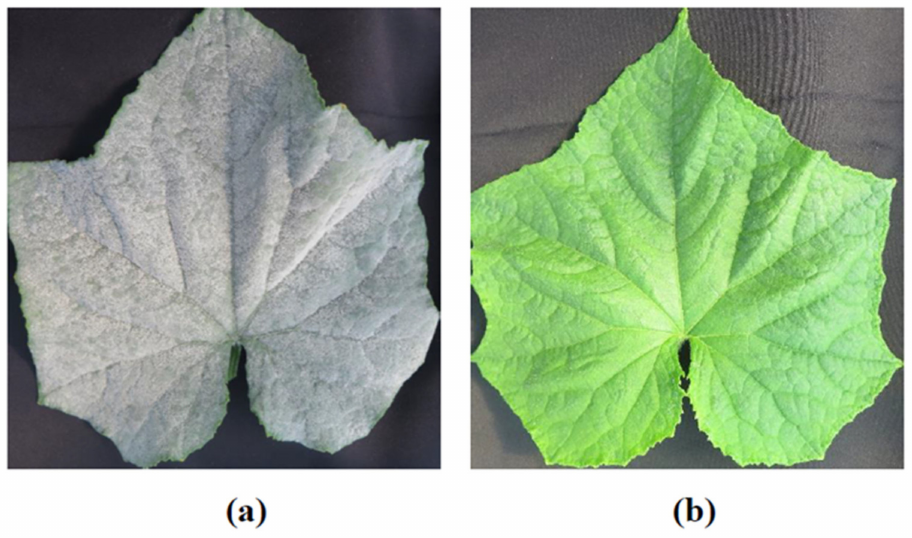
Figure 1. Typical phenotypic responses of PM infection. ( a , b ) Represent PM-susceptible and PM resistant phenotypes, respectively. Table 2. PM phenotypic evaluation and genotyping analysis results of 100 cucumber inbred lines. Line